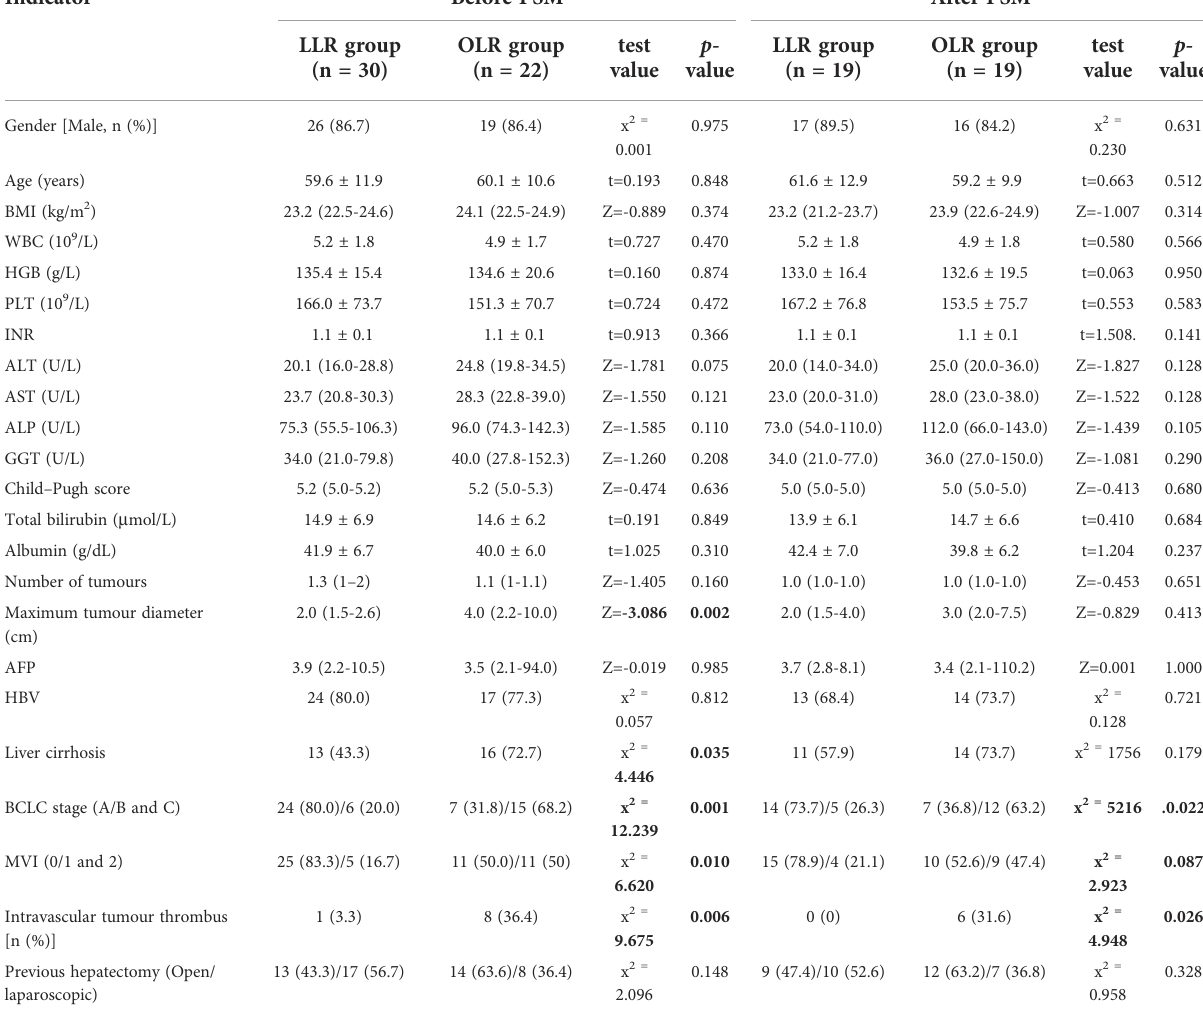
TABLE 1 Baseline preoperative clinical characteristics of the two patient groups before and after PSM.